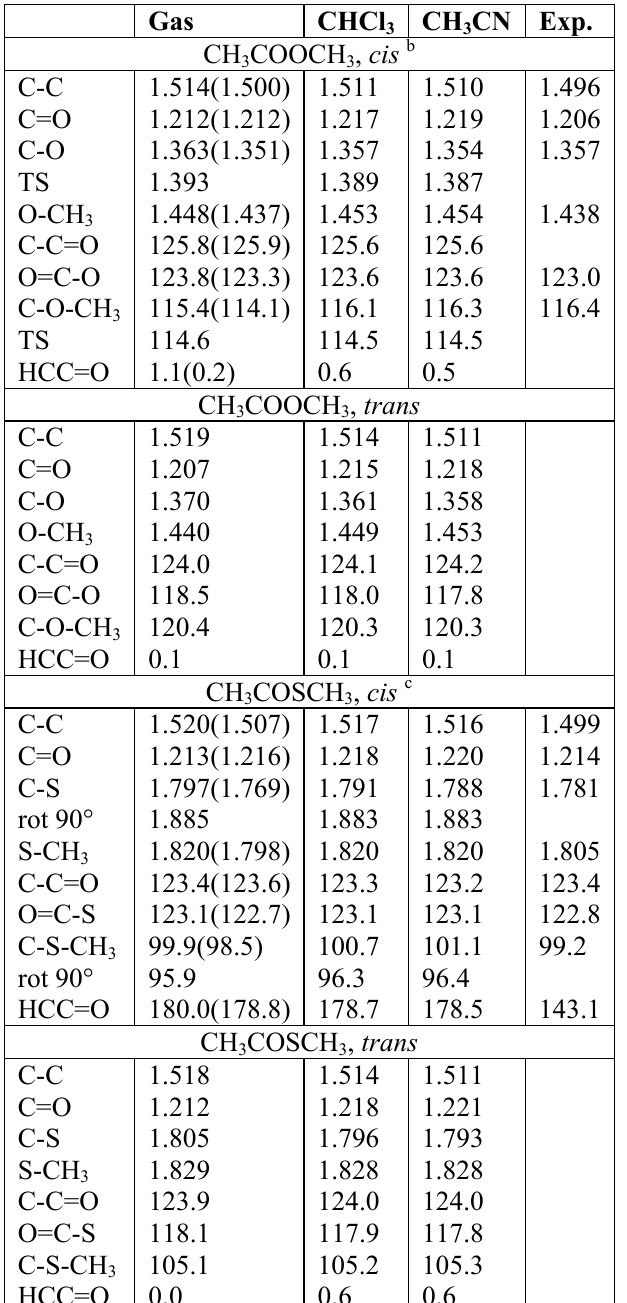
Table 2. Geometric parameters optimized at the B97D/aug-cc-pvTz and B97D/ aug-cc-pv(T+d)z levels for methyl acetate and thioacetic acid S-methyl ester, respectively a